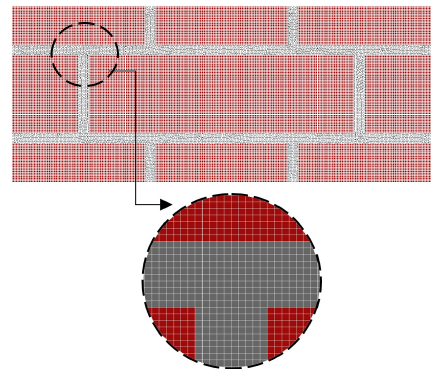
Figure 4. Masonry PUC finite element